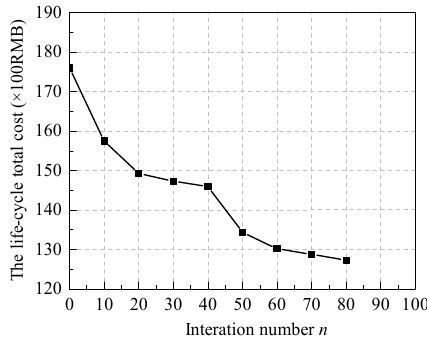
Figure 6. The relationship between reliability and weight coefficient